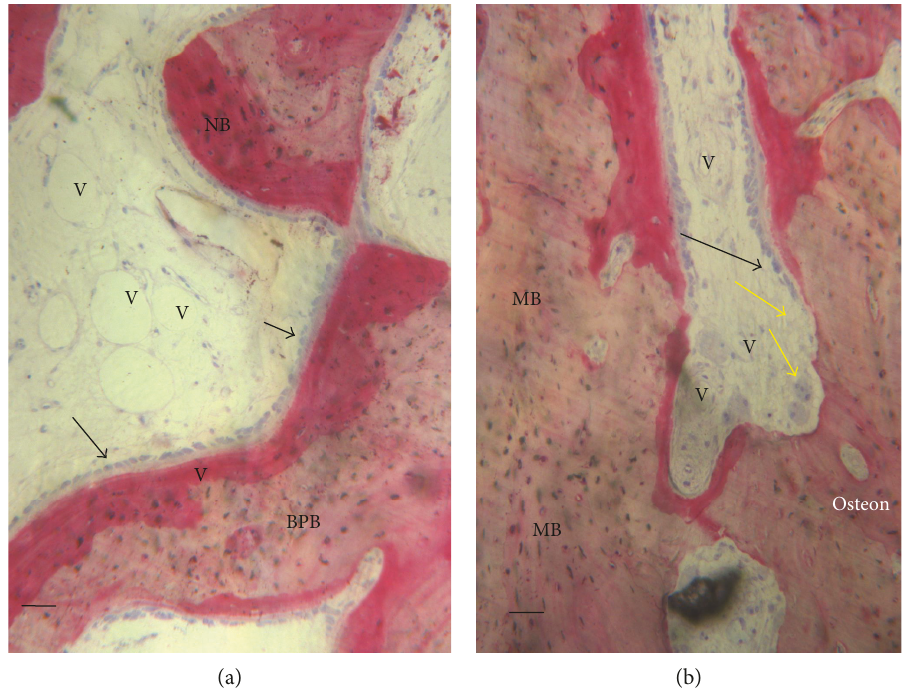
Figure 6: (a) BPB group. Bone tissue was deposited in the block material (BPB). No fi brous tissue was observed in the defect area. Vessels (V) were present in the central part of the bone defects. New bone (NB) and osteoblasts in close contact with the block material acid fuchsin and toluidine blue. Bar=100 μ . (b) BPB/BMSSCs group. Mature bone (MB) in the bone defect. Bone morphology was more mature and well organized, presenting a primary osteon. A basic multicellular unit of osteoclasts cells (yellow arrows) that dissolves an area of the bone surface and then fi lls it with new bone by osteoblasts (white arrows) to form haversian systems or osteons. A vessels (V) were present in the central part of the bone defects. Acid fuchsin and toluidine blue. Bar =100 μ